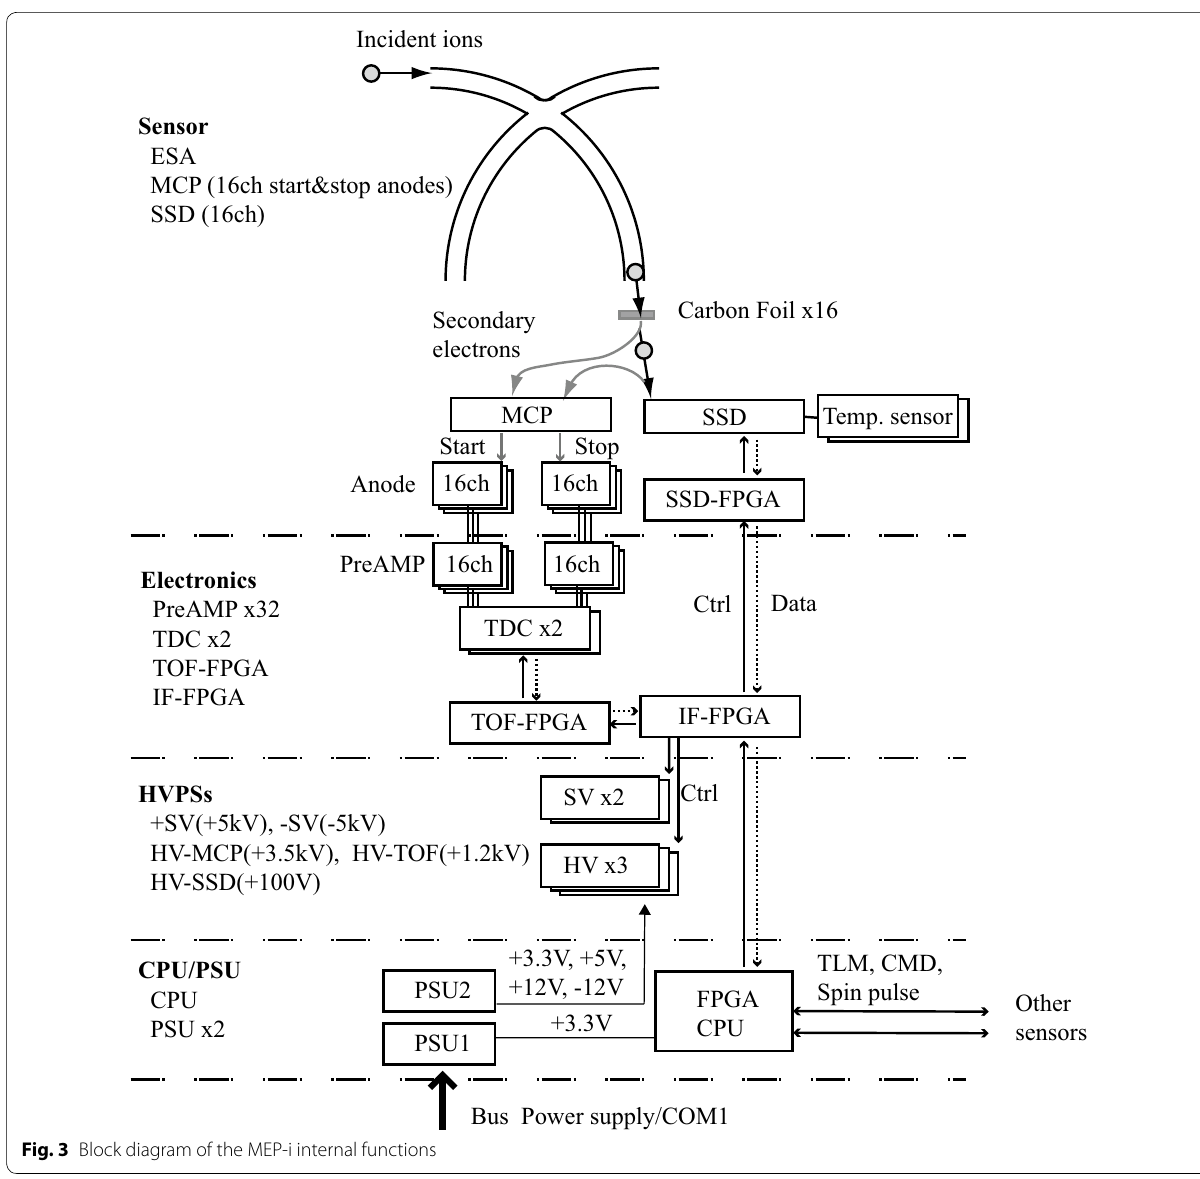
Fig. 3 Block diagram of the MEP-i internal